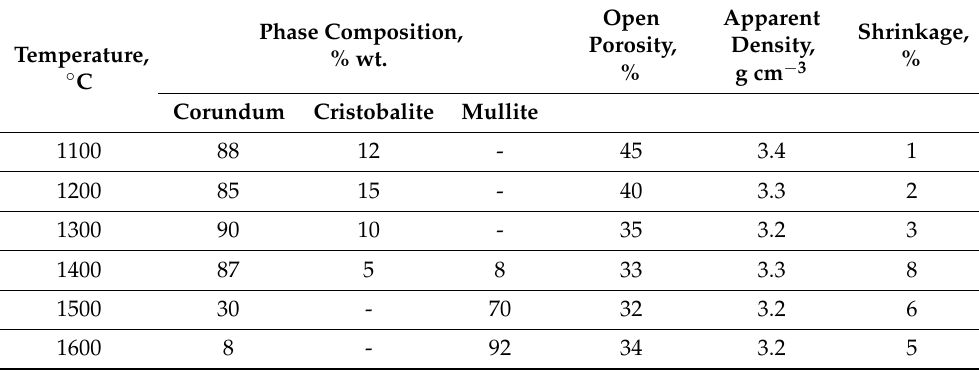
Table 13. Composition and properties of mullite (3Al 2 O 3 · 2SiO 2 ) ceramics produced using rice husk ash. Data from [52].